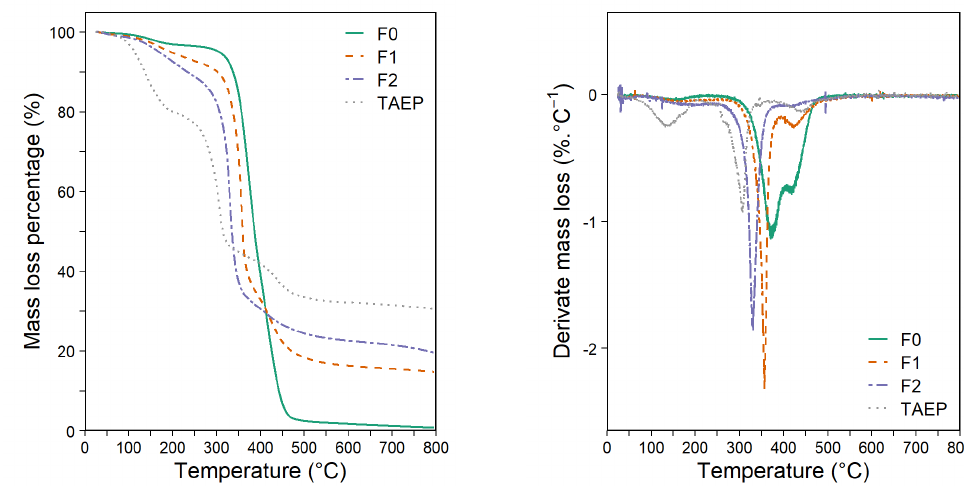
Figure 7. Curves of the thermogravimetric analysis performed under nitrogen and their derivatives for the TAEP monomer and the coating films with different phosphorus contents.